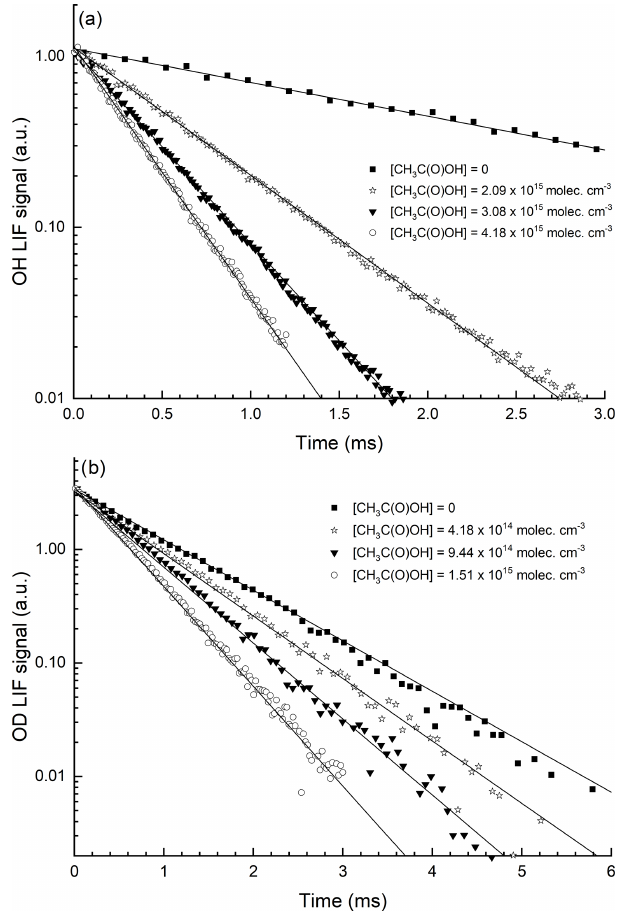
Figure 3. Exponential decay of the OH (a) and OD (b) LIF signals in 150TorrN 2 , at 293K and at four different CH 3 C(O)OH concen- trations. OH was generated by the photolysis of H 2 O 2 , and OD was generated by the photolysis of DNO 3 , both at 248nm. The lines are fits to the datasets using Eq. (1).